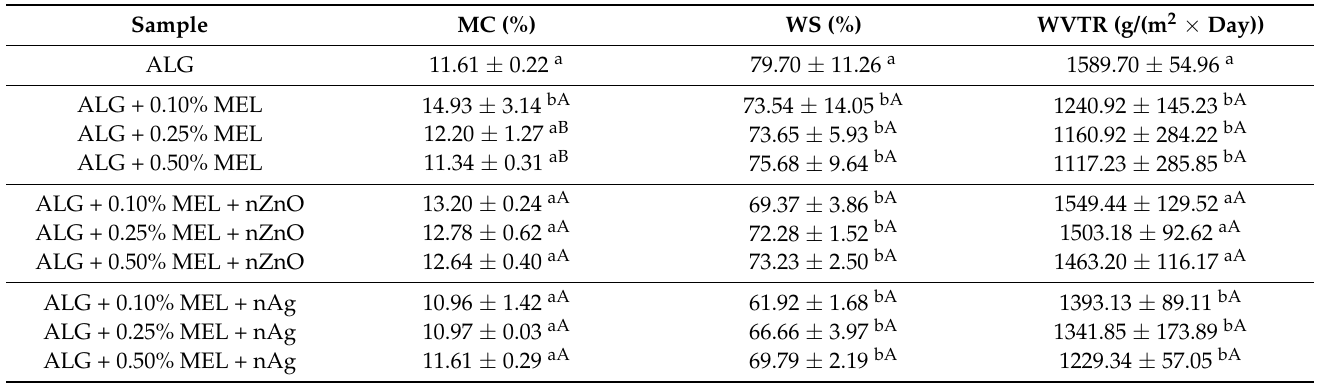
Table 2. Moisture content (MC), water solubility (WS) and Water Vapor Transmission Ratio (WVTR) of unmodified alginate films and films modified with melanin and melanin with